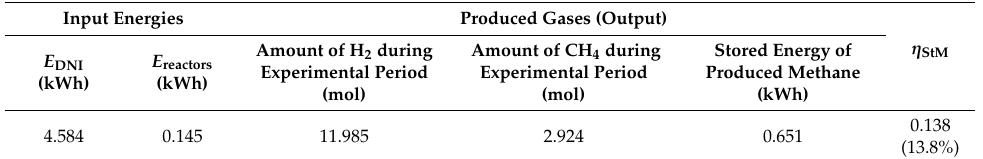
Table 1. Summary of power input and output for the methanation system and conversion e ffi ciency of solar energy to methane for sunny conditions (on 15th November 2019).